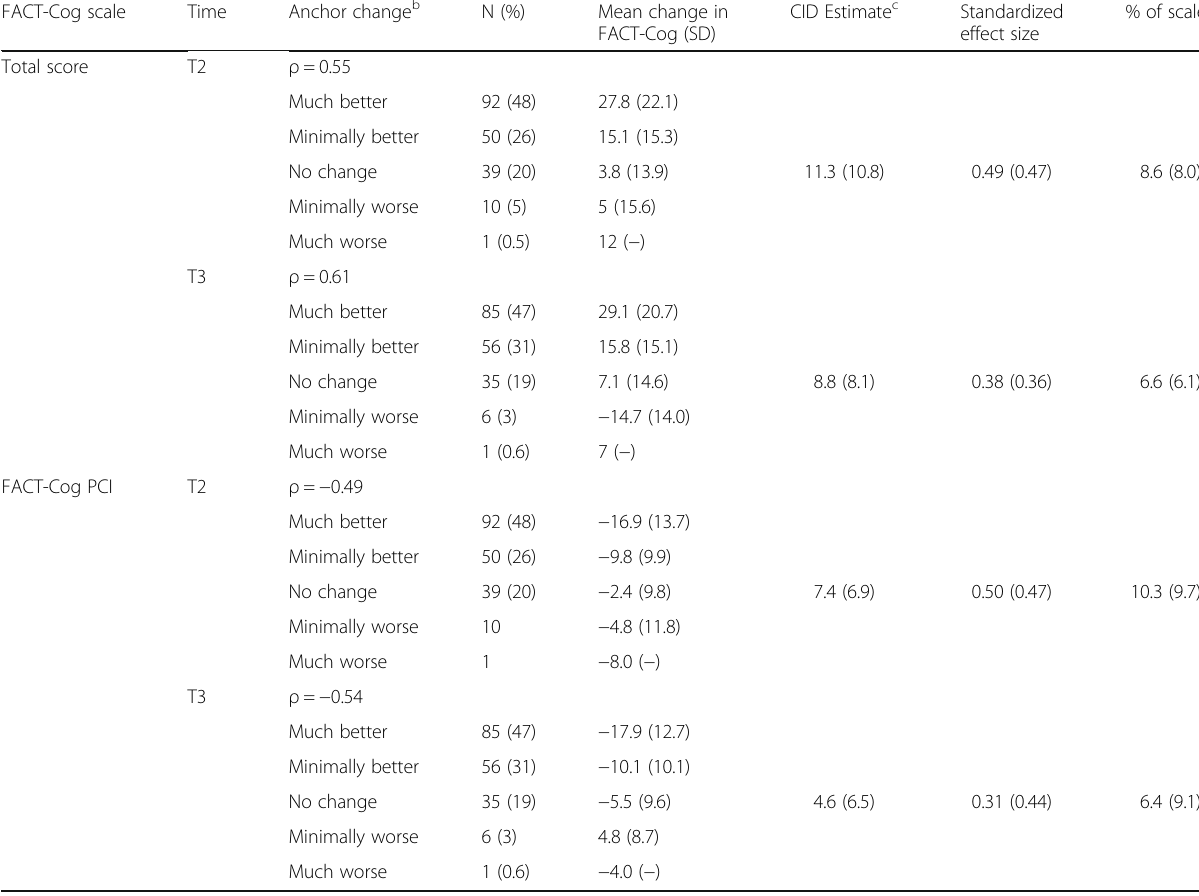
Table 3 Anchor-based MCT estimates for improvement for the FACT-Cog total score (33 item) and FACT-Cog-PCI based on changes from baseline at post-intervention (T2) and six month follow-up (T3) using the primary anchor EORTC-CF. Results from sensitivity analysis shown in parenthesis in the last three columns a . Correlations, ρ , are for the change in the FACT-Cog total score or PCI subscale and the change in anchor (categorized) FACT-Cog scale